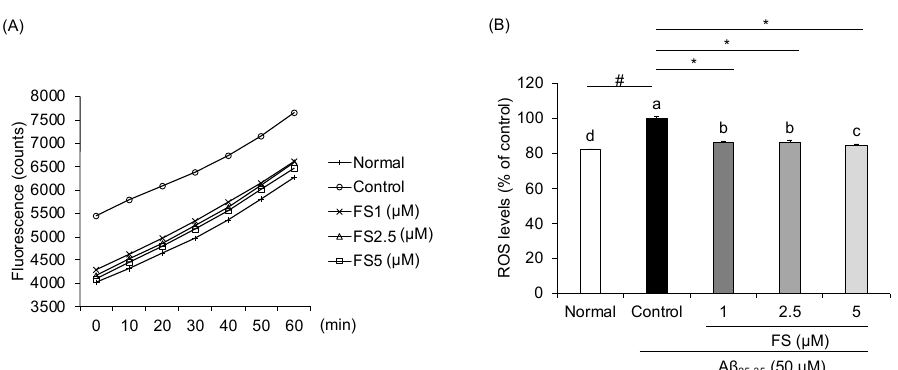
Figure 4. Effects of N -feruloyl serotonin on reactive oxygen species generation in A β 25–35 -induced SH-SY5Y cells. ( A ) Fluorescence of FS within 60 min. ( B ) ROS level of FS at 60 min. Values present means ± SD ( n = 4). a–d Means with different letters are significantly different ( p < 0.05) by Duncan’s multiple range test. # p < 0.01 vs. normal; * p < 0.05 vs. control. FS, N -feruloyl serotonin; ROS, reactive oxygen species.